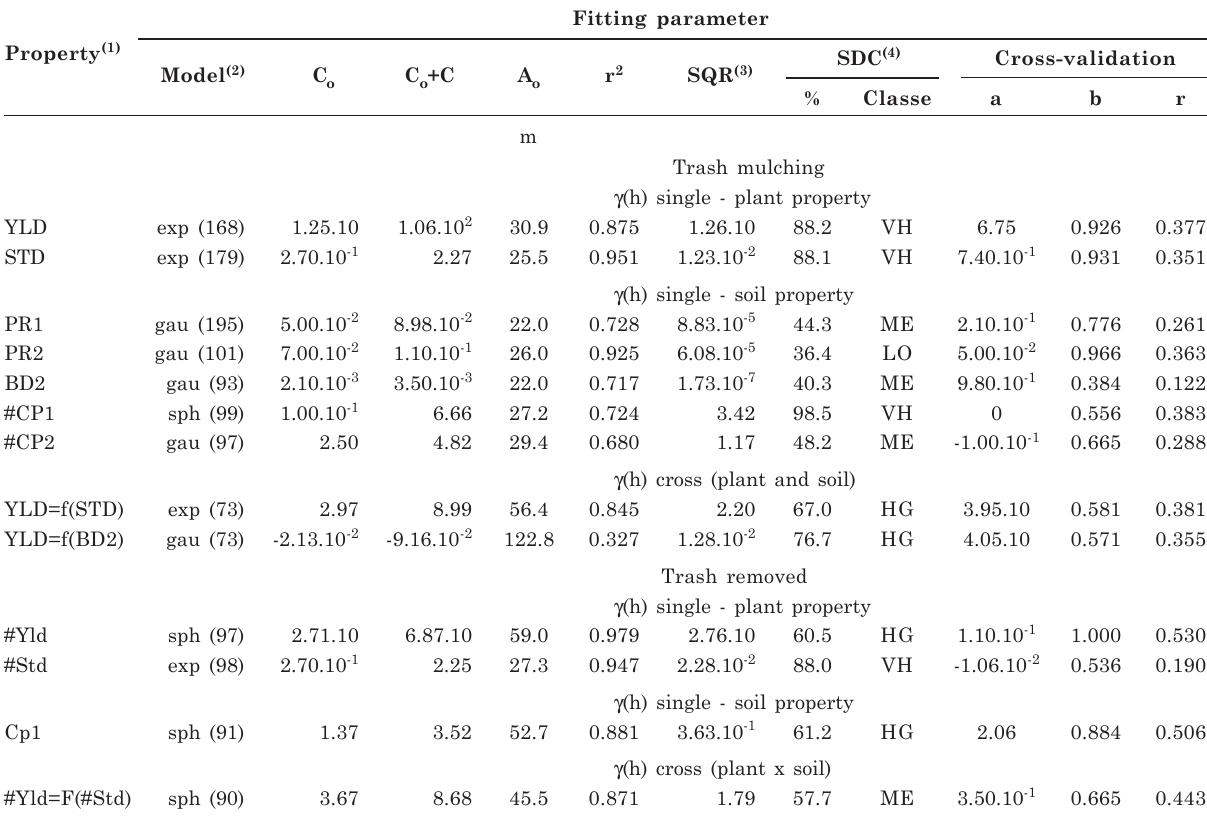
Table 3. Parameters of semivariogram and cross-validations for the properties of sugarcane and physico- chemical properties of an Ultisol, in the treatment in which the trash was left on the ground (mulching) and was removed from the